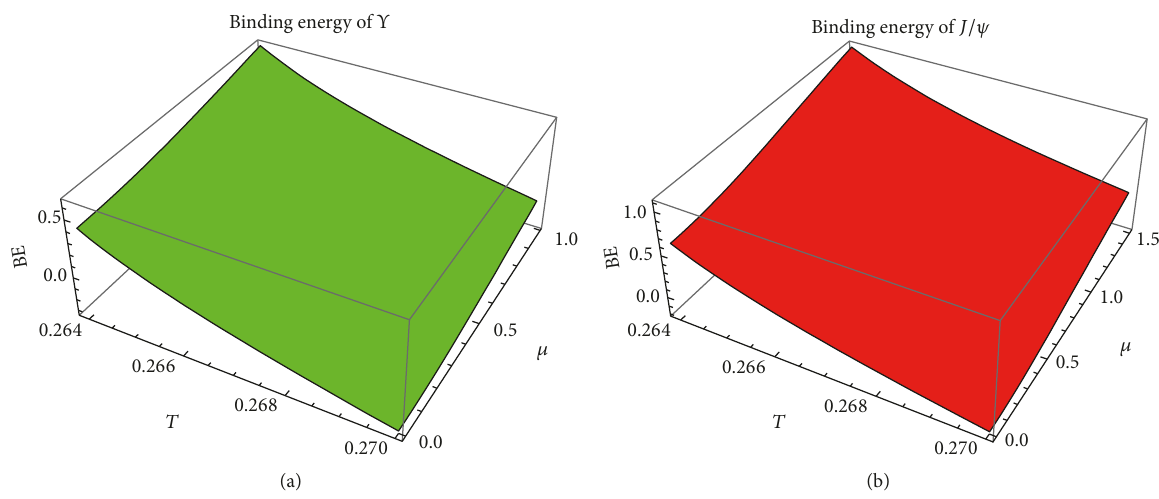
Figure7:Dependenceof Υ bindingenergy(inGeV)ontemperature 𝑇/𝑇 𝑐 (a)anddependenceof 𝐽/𝜓 bindingenergy(inGeV)ontemperature 𝑇/𝑇 𝑐 (b) in 3